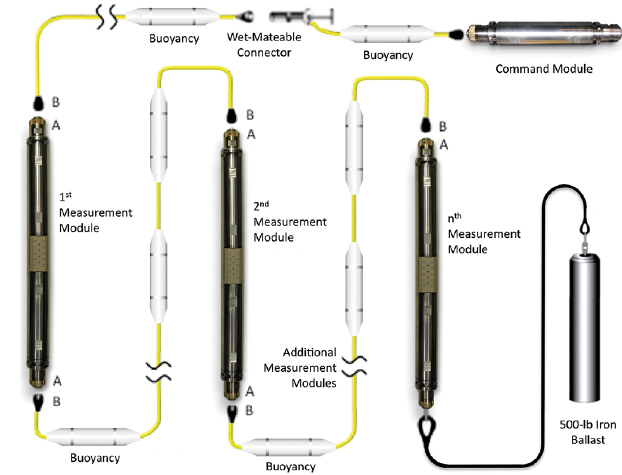
Figure 1. SCIMPI schematic showing the modules connected to each other to form a single string that was deployed in an open borehole to depths up to